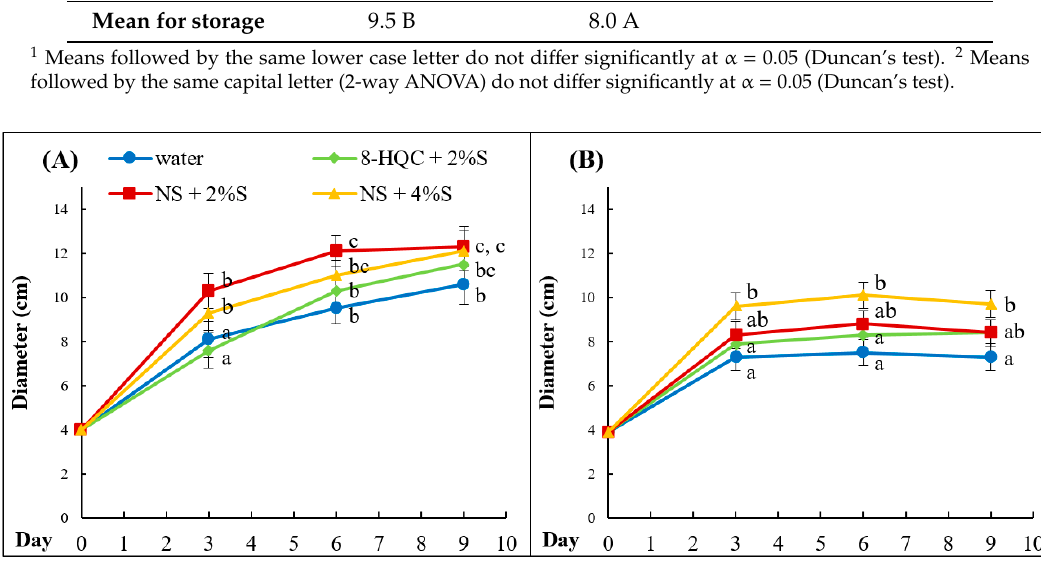
Figure 2. Flower diameters of cut non-stored peony flowers ( A ) and cut peony flowers after 12 weeks storage ( B ). Value are expressed as means ±SD of triplicate assays. Vertical bars represent standard deviations of the means. Means followed by the same lower case letter do not differ significantly α = 0.05 (Duncan’s test). Analyses were done separately for non-stored and stored flowers.